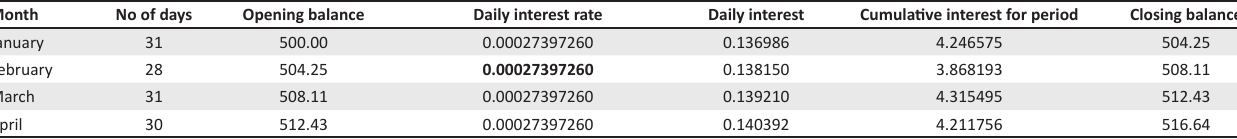
TABLE 1: Cumulative interest based on daily interest calculations and monthly compounding.